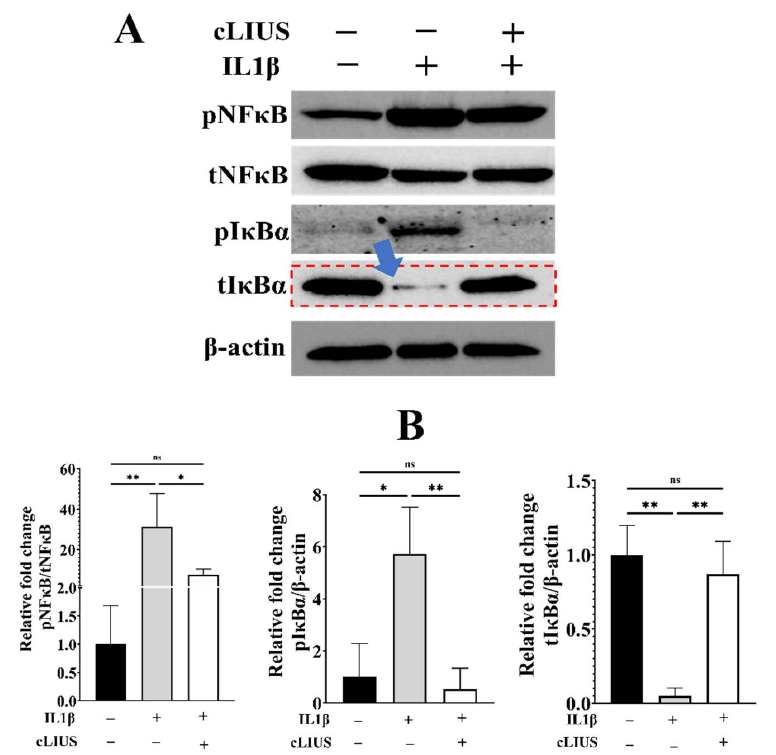
Figure 6. Phosphorylation of NF κ B and I κ B α . MSCs were seeded on TCP plates and treated as depicted in Figure 1. Total cell lysates were obtained and analyzed by Western blotting using specific antibodies. ( A ) Protein expression of phospho-NF κ B, total NF κ B, phospho-I κ B α and total I κ B α in indicated samples by Western blotting; β-actin was used as a loading control. ( B ) Blots were quantified using ImageJ TM software and presented. Data are shown as the mean ± standard deviation of samples and p -value represents statistical significance (* p < 0.05; ** p < 0.01; and ns-nonsignificant). ‘+’ indicates presence and ‘–’ indicates absence.